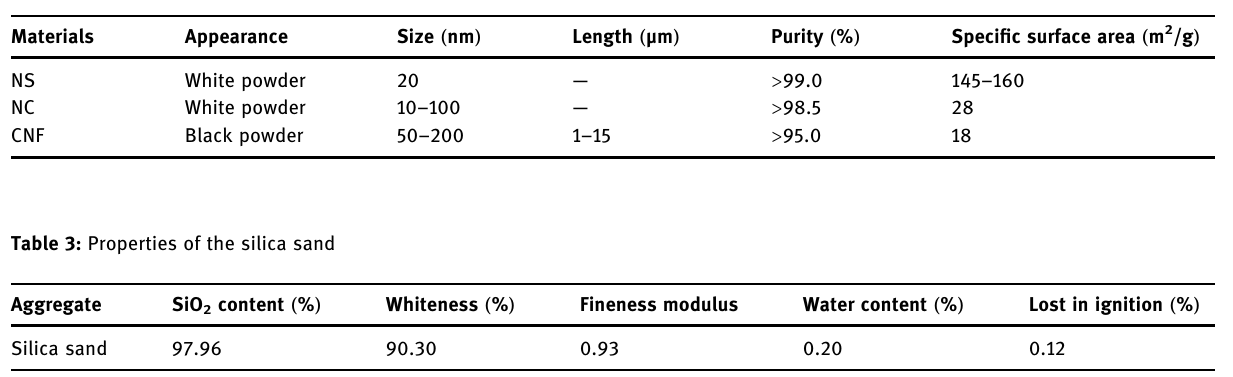
Table 2: Properties of the nanomaterials